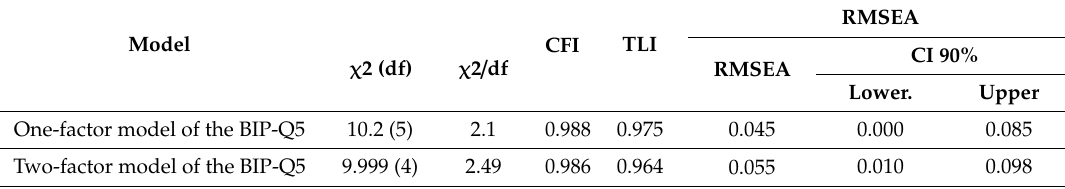
Table 3. Fit indices for the models proposed (calibration sample n = 505).